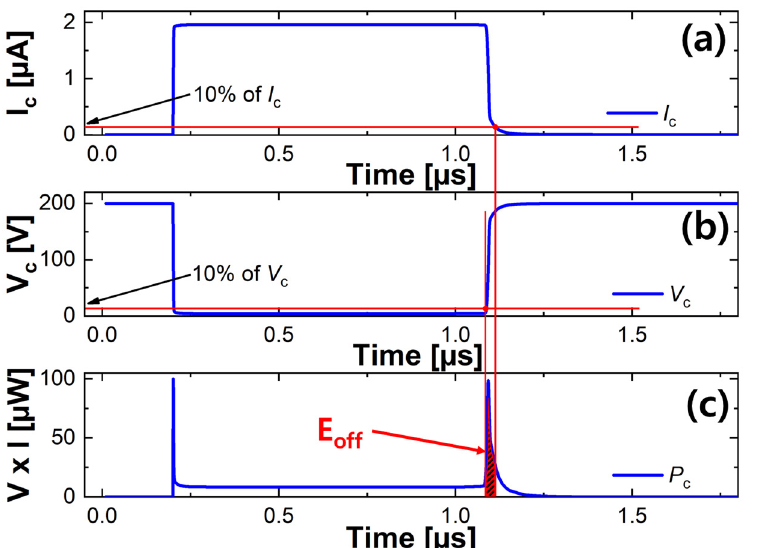
Figure 7. The way to calculate the turn-off loss: ( a ) the turn-off waveform of collector current; ( b ) collector current; and ( c ) power dissipation. Red lines are drawn vertically at times corresponding to 10 percent of collector total current and 10 percent of collector voltage.